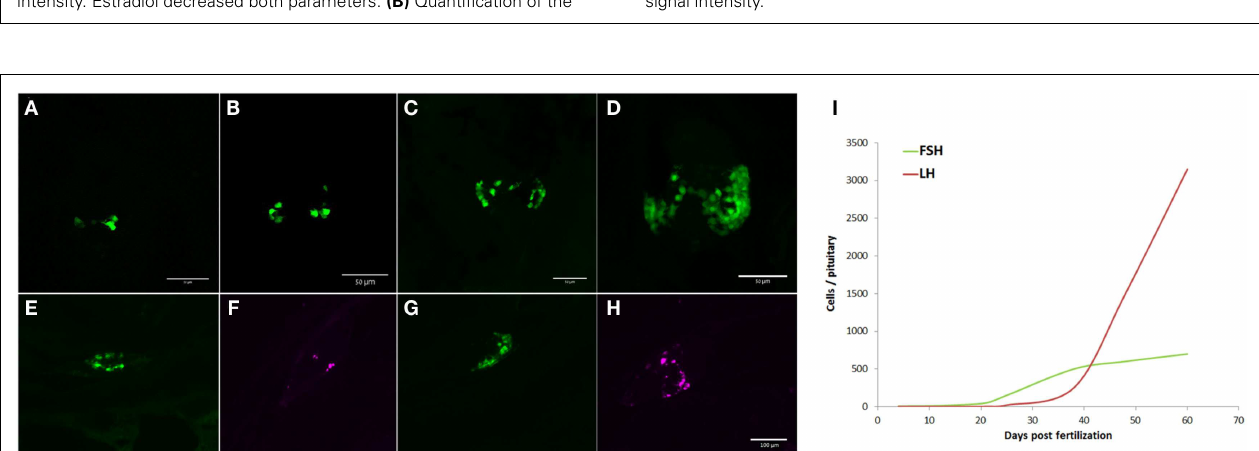
FIGURE 7 | Ontogeny of gonadotrope cells in zebrafish . FSH (green) and LH (magenta) cell patterns were followed throughout development. (A–D) Proliferation of FSH cells during early development. At 4dpf (A) 5–6 cells can be found in the pituitary. Cell number rises gradually as the fish develops [ (B) -7dpf; (C) -14dpf; and (D) -21dpf]. LH cells begin appearing at